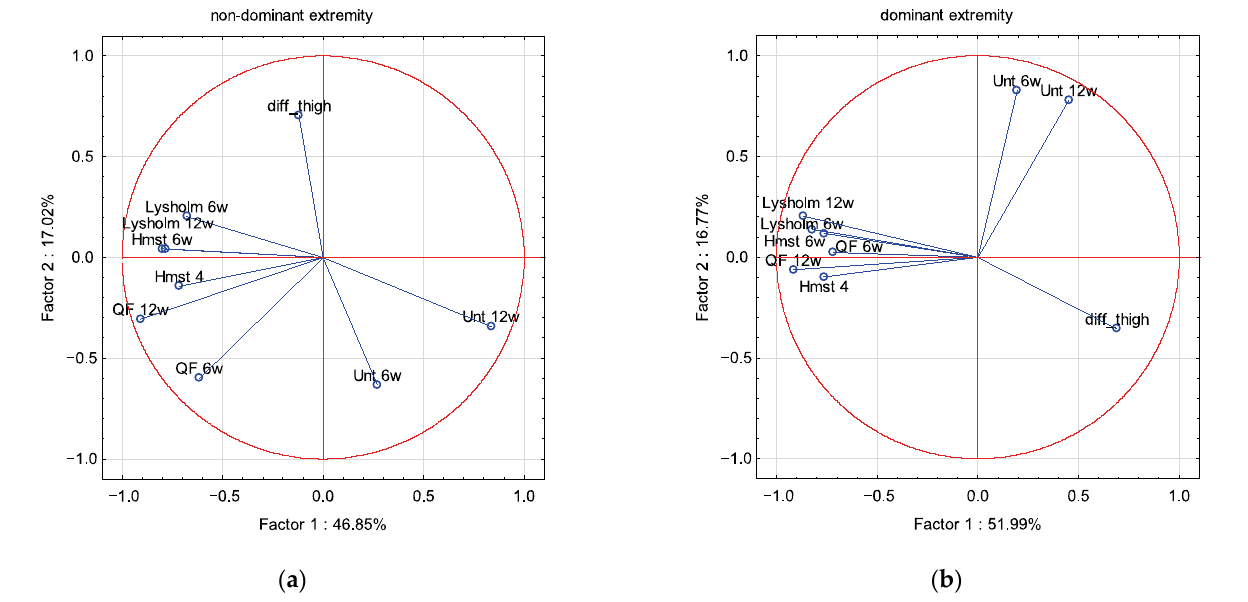
Figure 3. A graphic illustration of Principal Components Analysis of Lysholm, Unterberger test and muscle strength. Projection of the variables on the factor plane of the first two principal components for the non-dominant ( a ) and dominant ( b ) extremity.